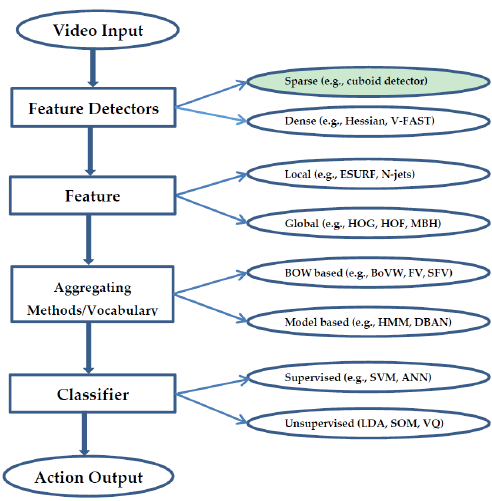
Figure 5. Components of space ‐ time ‐ based approaches. ESURF: Enhanced Speeded ‐ Up Robust Features; HOG: histogram of oriented gradients; HOF: histogram of optical flow; MBH: motion boundary histogram; BOW: bag ‐ of ‐ words; BoVW: Bag ‐ of ‐ Visual ‐ Words; FV: Fisher Vector; SFV: Stacked Fisher Vector; HMM: Hidden Markov Model; DBAN: Dynamic Bayesian Action Network; SVM: support vector machine; ANN: Artificial Neural Network; LDA: Latent Dirichlet Allocation; SOM: Self Organizing Map; VQ: vector quantization.